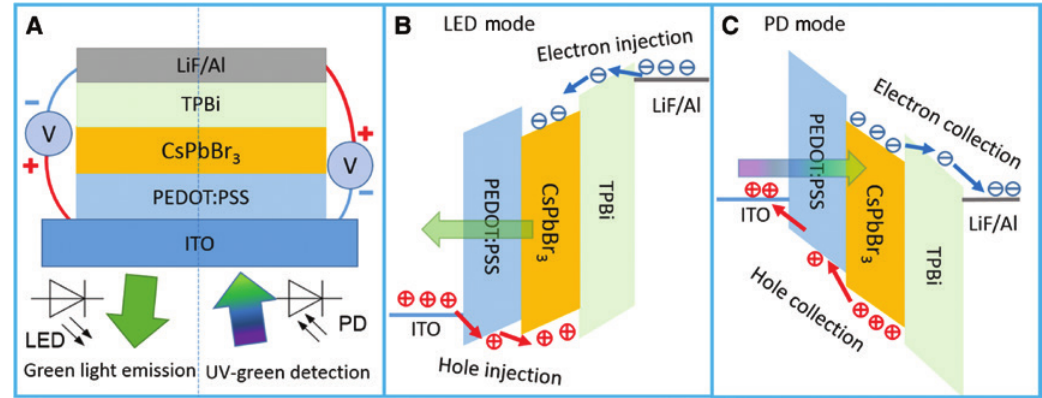
Figure 3: Schematics of the working mechanism of the bi-functional diodes. (A) Schematic cross-sectional view of the bi-functional diode and its EL and photo-response dual-function. Schematic diagrams illustrating (B) charge injection for light-emitting process when the bi-functional diode is operated at a forward bias and (C) charge extraction for light detection when it is operated at a reverse bias.